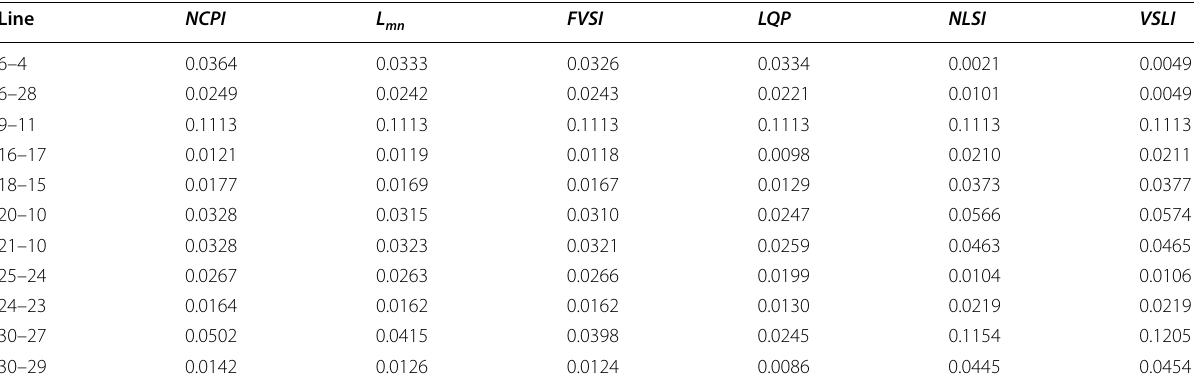
Table 1 The line stability indices for the IEEE 30-bus system in the base case loading Line